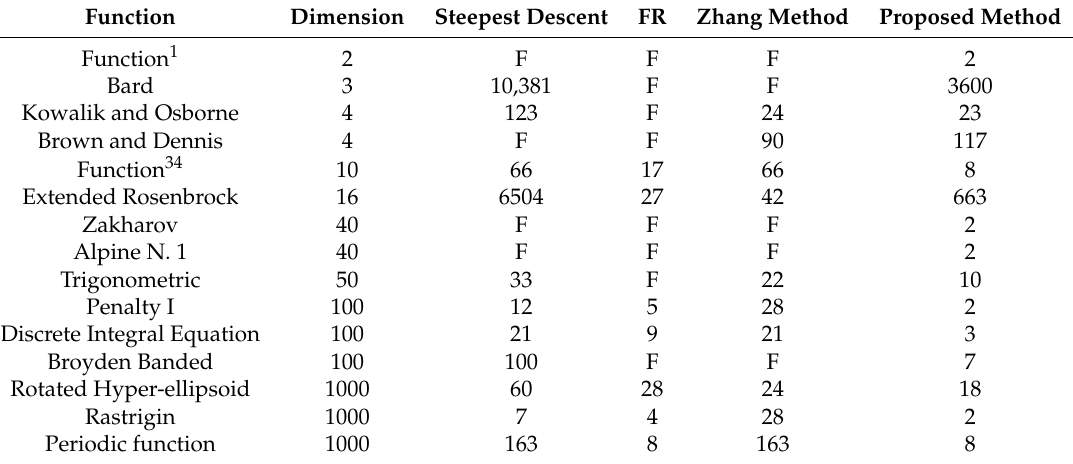
Table 2. Iteration numbers (NI) for different methods.